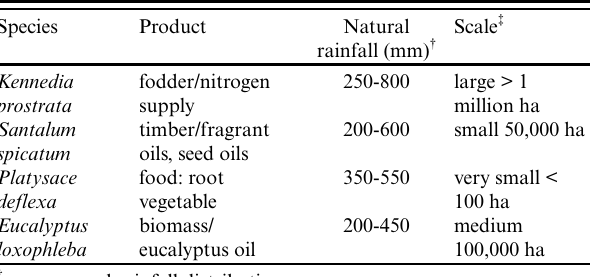
Table 4 . Native species with commercial potential for catchments altered by climate